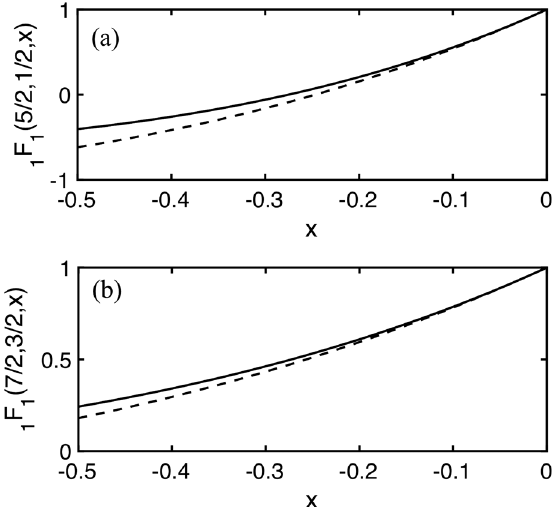
FIG. 3. The confluent hypergeometric functions (solid lines) and their small-argument approximation (dashed